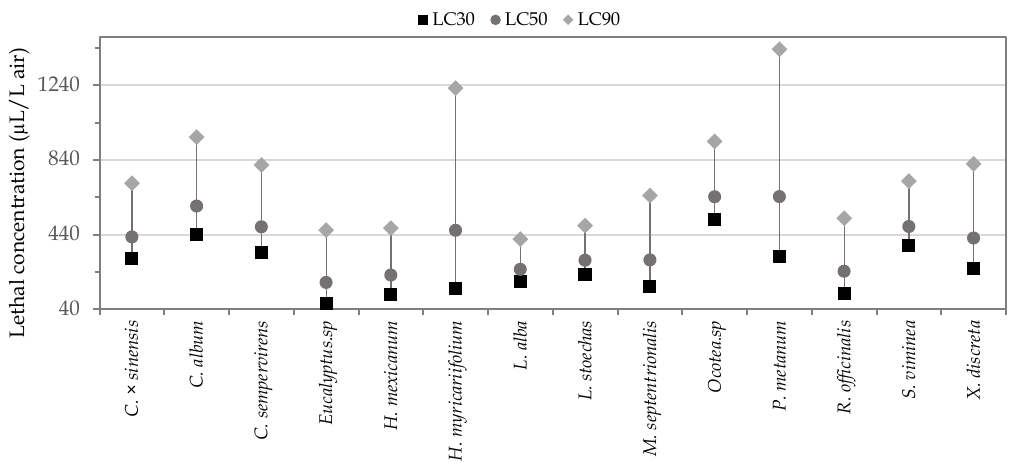
Figure 8. Scatter plot of the different lethal concentrations of fumigant toxicity for the 14 active EOs.